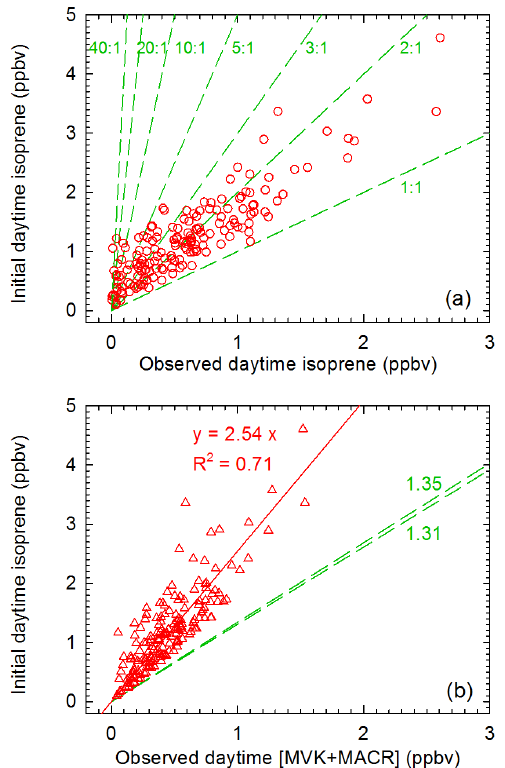
Figure 5. (a) Comparison of observed and initial isoprene mixing ratios during the day. Green dashed lines denote slopes for dif- ferent ratios of initial to observed isoprene. (b) Relationship be- tween initial isoprene and observed [MVK + MACR] during the day. The green dashed lines denote slopes for different yields of (MVK + MACR) of the OH-initiated oxidation of isoprene for the ranges of the observed NO distribution (Fig. S7).